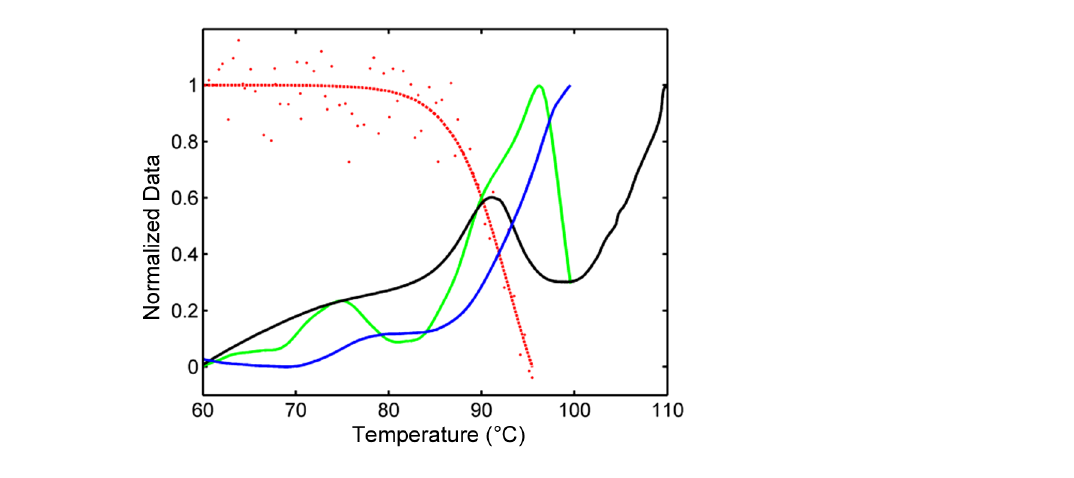
Fig. 3. Thermal denaturation of Construct 1 monitored by CD, DSC, and fluorescent dye assay. The high melting point of Construct 1 is ambiguous but above 90 ˚ C by multiple techniques. The CD data from Fig. 2 is plotted (red) along with the raw fluorescent dye data (blue), the first derivative of the dye data (green) and the results of differential scanning calorimetry (black). All data is normalized from zero to one in the range of 60–110 ˚ C for best visibility of the changes.